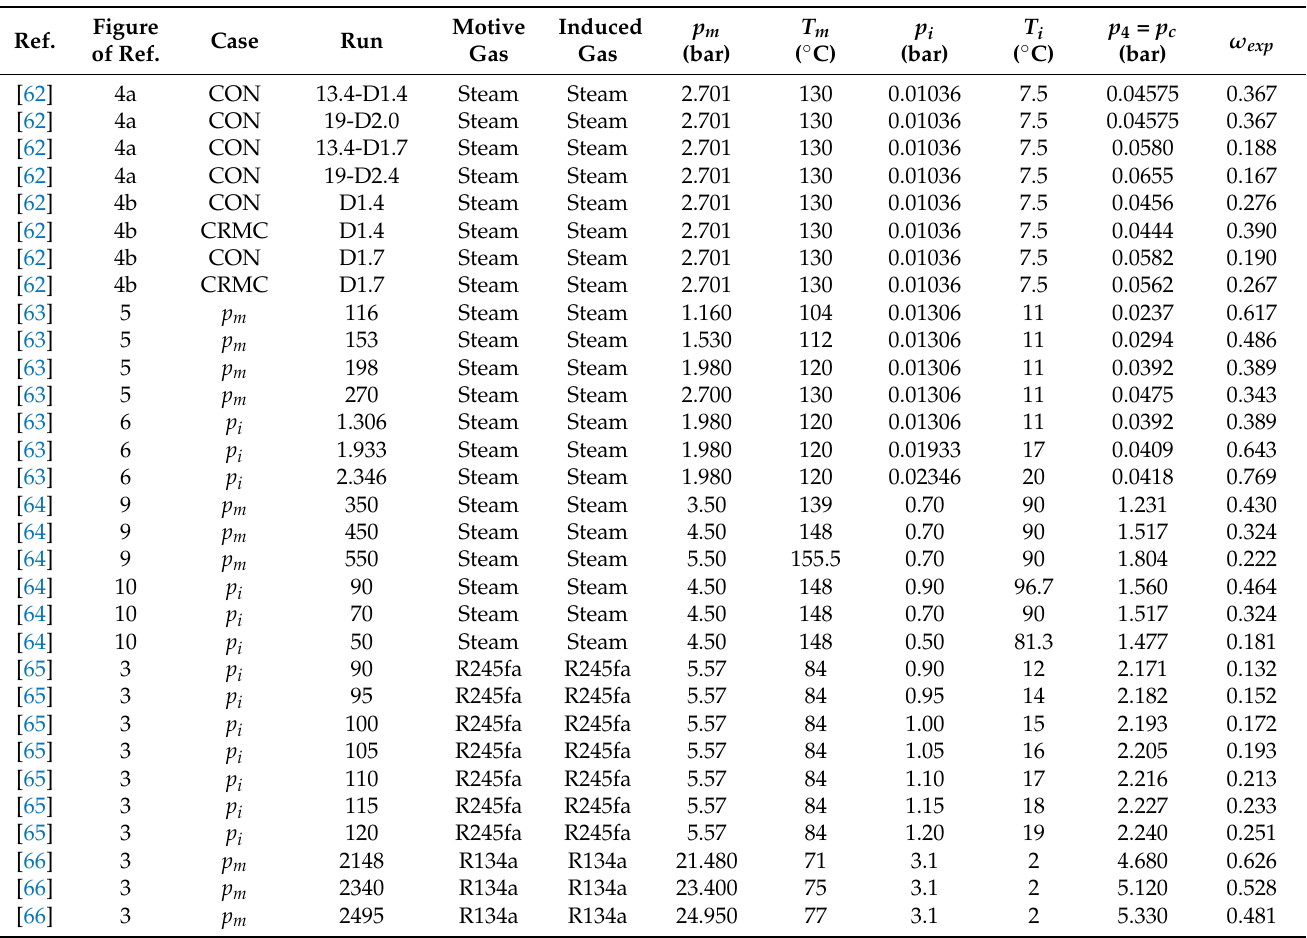
Table 3. Operating data of the second series of benchmark ejectors built and tested experimentally by the authors indicated in the first